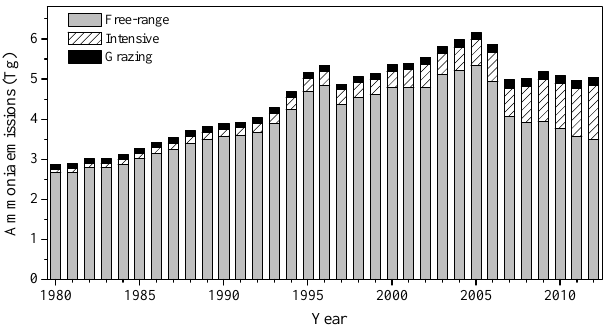
Figure 2. Interannual variation in NH 3 emissions from livestock manure for three different rearing systems.